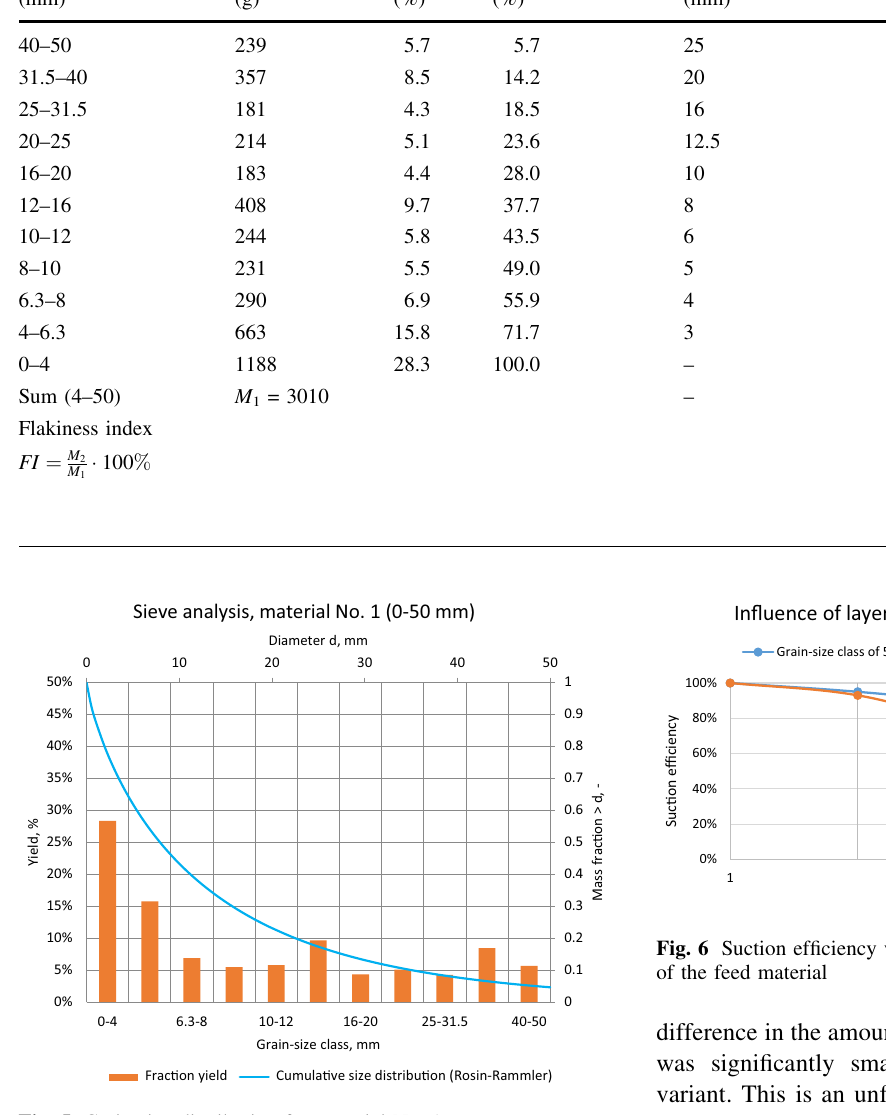
Fig. 5 Grain-size distribution for material No. 1